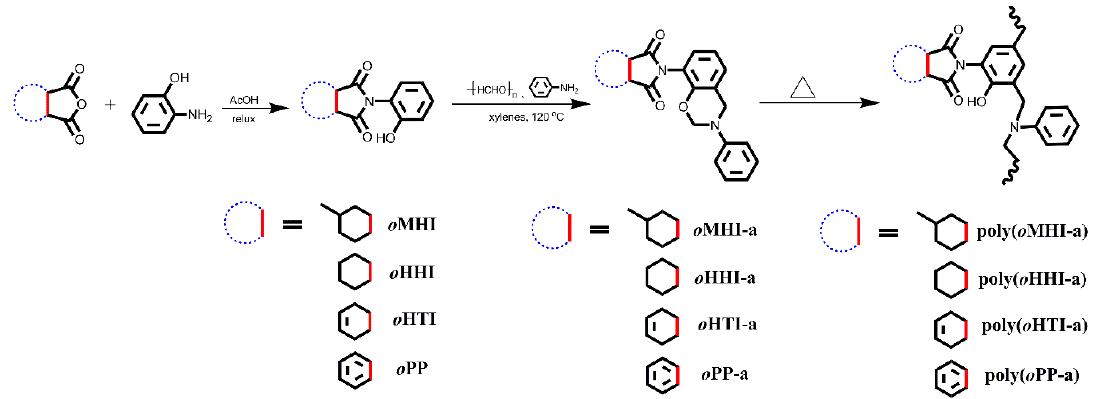
Scheme 2. Synthesis and polymerization of ortho -imide functional benzoxazine monomers.